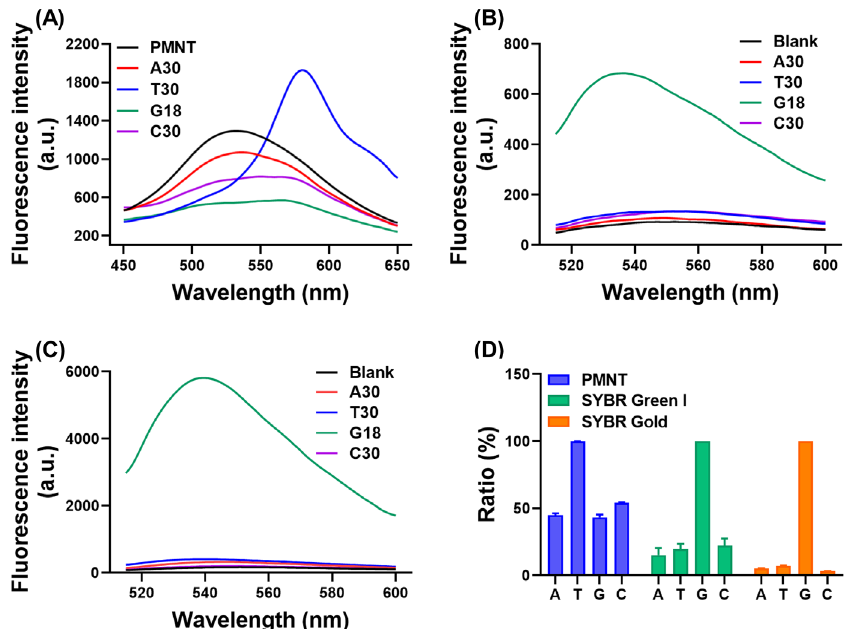
Figure 4. The fluorescence spectra of PMNT ( A ), SGI ( B ), and SYBR Gold ( C ) in response to different ssDNA sequences. ( D ) The ratio of other sequences compared with the highest signal. For the CCP-based method, the fluorescence ratio of poly-T was set as 100%. The intensity of poly-G was set as 100% for the SGI and SYBR Gold-based methods. The concentration of PMNT was 5 μM, and the concentration of SGI and SYBR Gold was 0.5×.